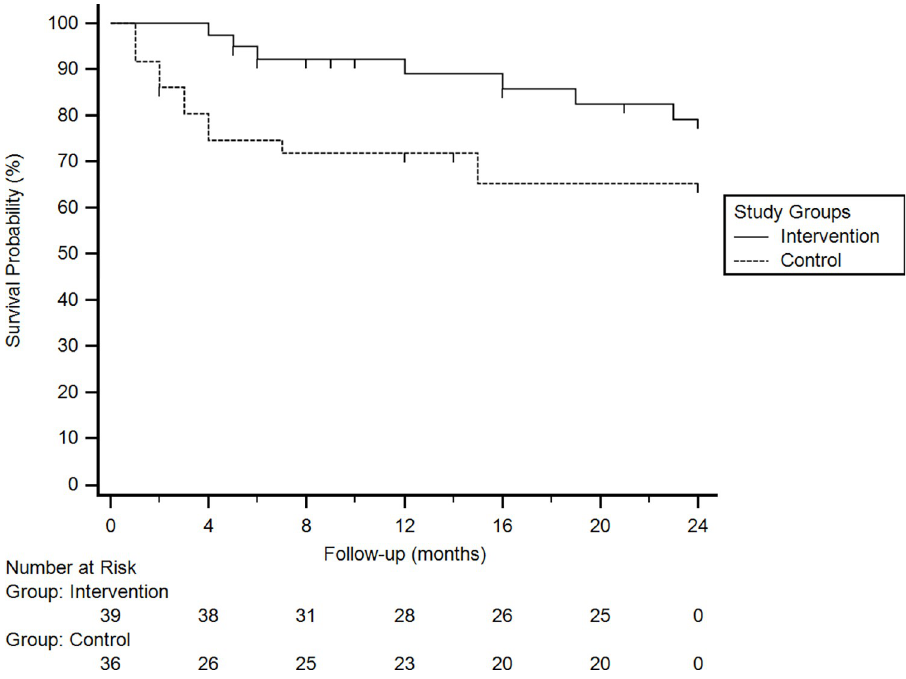
Fig 2. Kaplan-Meier plot of the cumulative probability of complete surgical success at the 24-month follow-up.